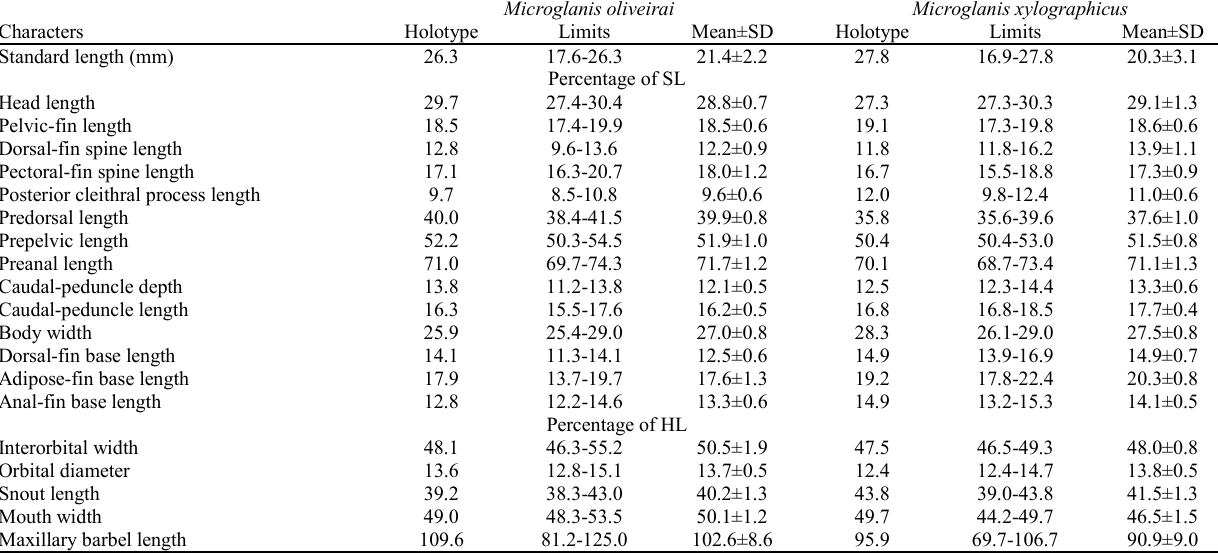
Table 1. Morphometric data of Microglanis oliveirai (n=32) and Microglanis xylographicus (n=18). SD = standard deviation. Limits include the lower and higher numbers in holotype and paratypes.